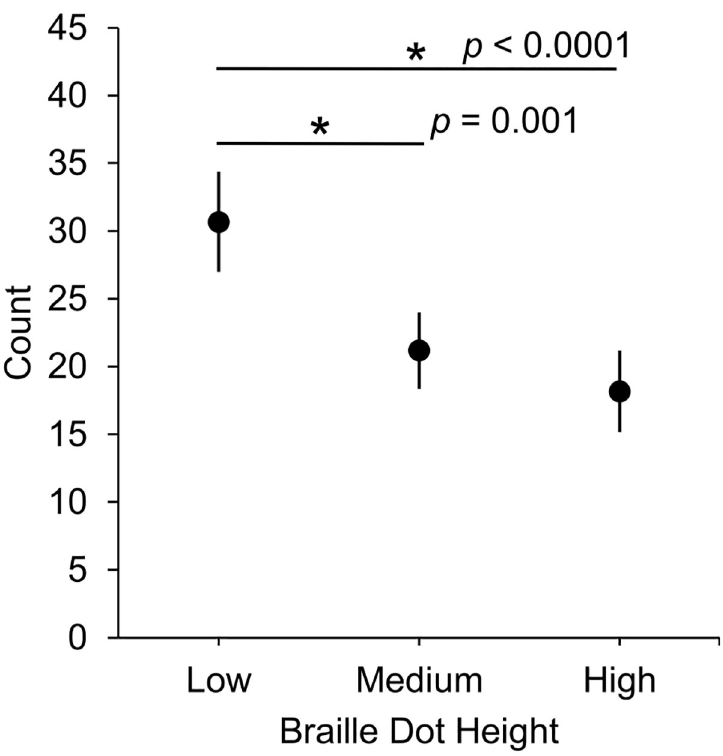
Fig 3. Average number of primary regressions (with SEMs) at three braille dot